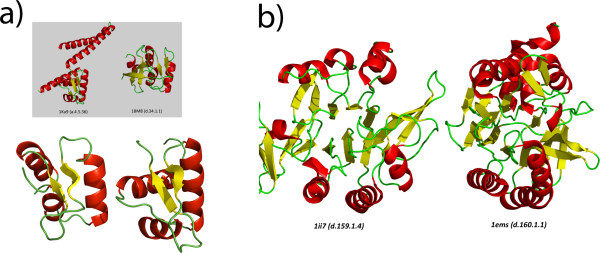
Examples of two pairs of proteins with structural similarity between profiles that can be considered as false positives according to SCOP definition. A) two proteins belonging to two different SCOP folds. The similarity in structure is evident from the figure and is also noted in the SCOP database. The structure on the right is 1KU9, N terminal part and the structure on left is 1BM8 (winged helix domain). The inset shows the full length proteins and the foreground picture shows the superposition of the part of each protein suggested to be homologous by AlignHUSH. B) two proteins belonging to different SCOP folds in the same class. Visual inspection does not seem to bring out the similarity between the two proteins and perhaps this is the reason why they are classified into two different folds by SCOP. The DALI Z score between the two proteins is around 8.0 covering 150 residues with an RMSD of 3.3 Å.